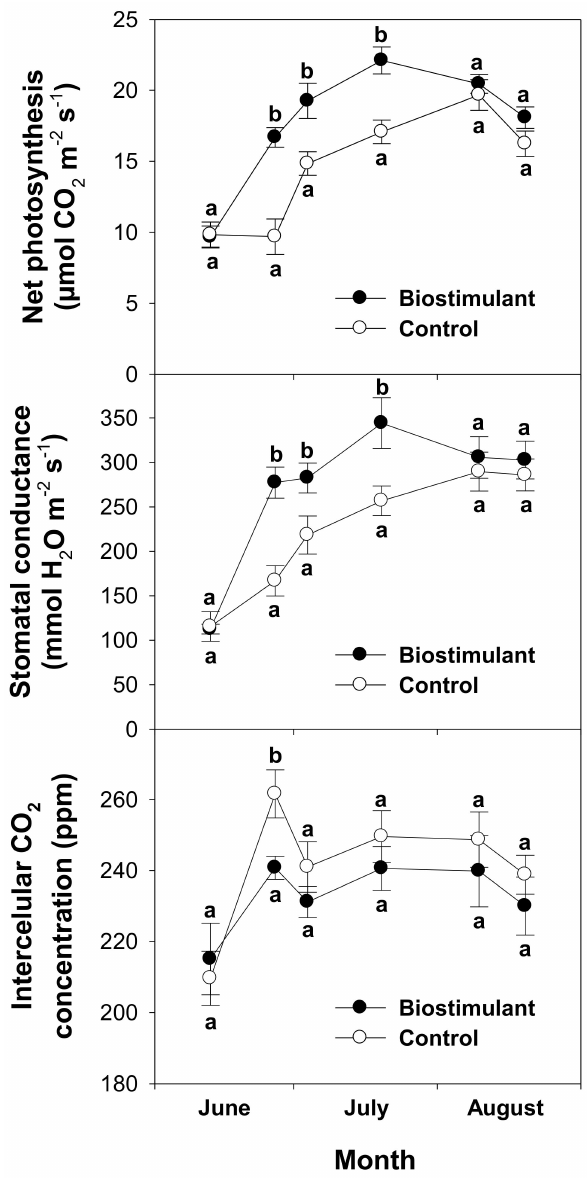
Figure 2. Photosynthetic activity, stomatal conductance and intercellular CO 2 concentration of the leaves of treated and control potted trees. Bars represent standard errors. For each date of measurement, means accompanied by di ff erent letter are significantly di ff erent at p <